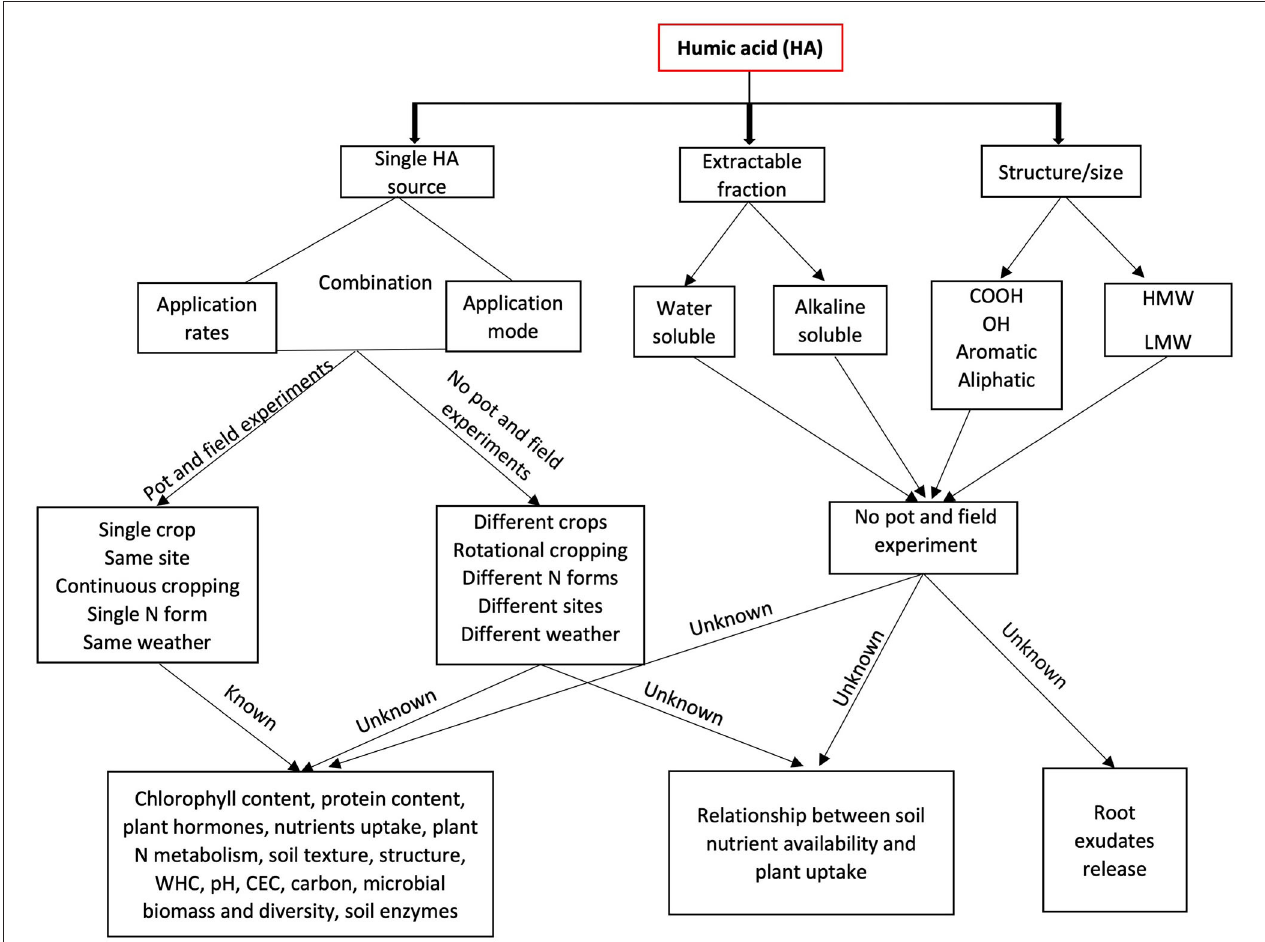
FIGURE 3 | Model showing known and unknown research that have been conducted under pot and field experiments on crop yield and quality, soil quality and research gaps that need to be elucidated. COOH, carboxyl group; OH, phenolic group; HMW, high molecular weight; LMW, low molecular weight; WHC, water holding capacity; CEC, cation exchange